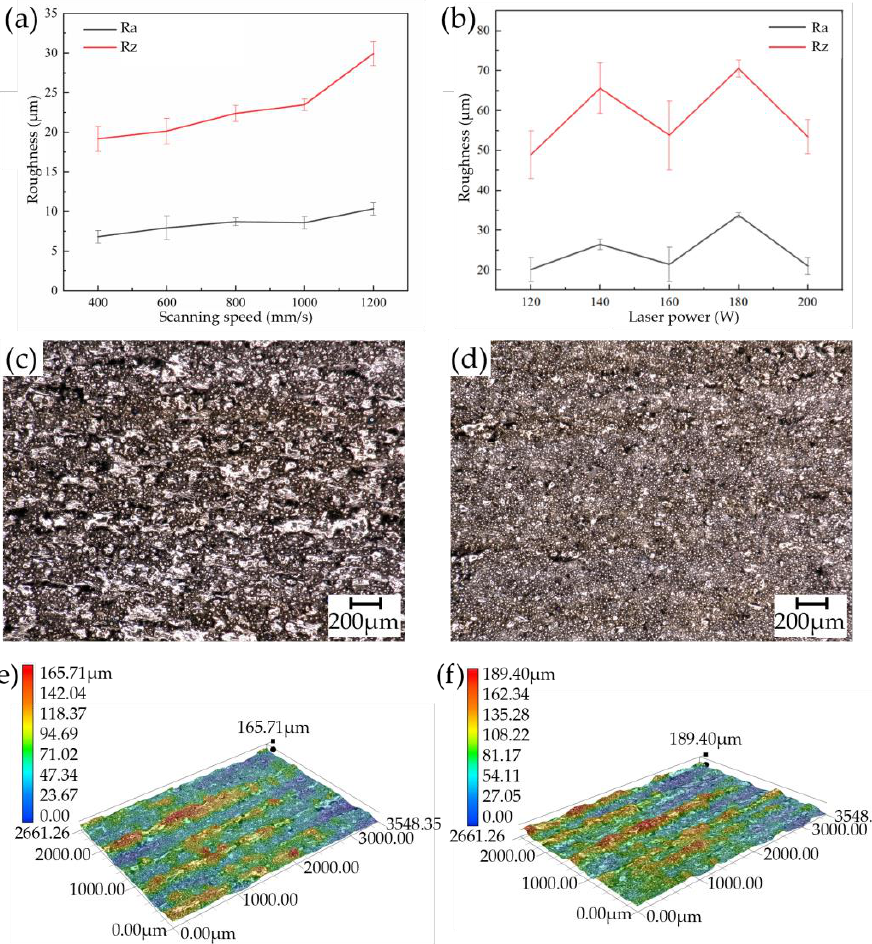
Figure 11. Morphology and roughness of lower side under different parameters: ( a ) scanning speed; ( b ) laser power; ( c ) 160W, 400 mm/s; ( d ) 160W, 1000 mm/s; ( e ) 120W, 800 mm/s; ( f ) 200W, 800 mm/s. ( b ) laser power; ( c ) 160 W, 400 mm/s; ( d ) 160 W, 1000 mm/s; ( e ) 120 W, 800 mm/s; ( f ) 200 W, 800